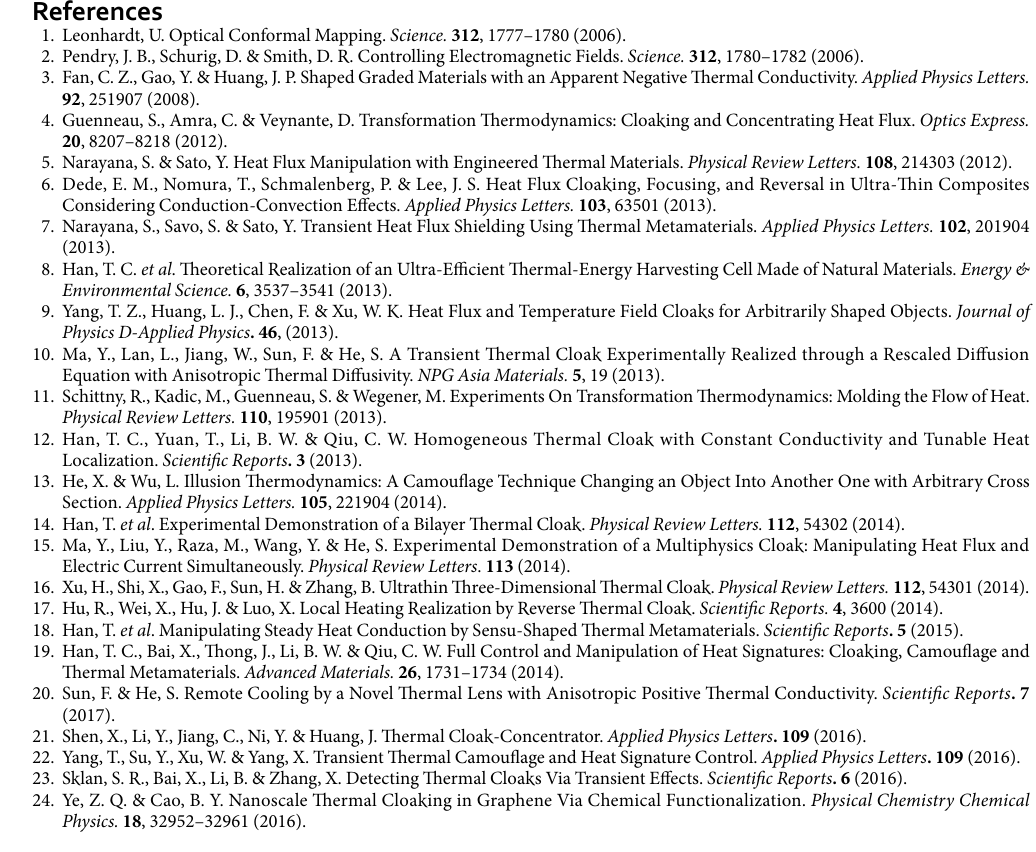
8 Scientific REPORTs | 7: 7541 | DOI:10.1038/s41598-017-07902-5